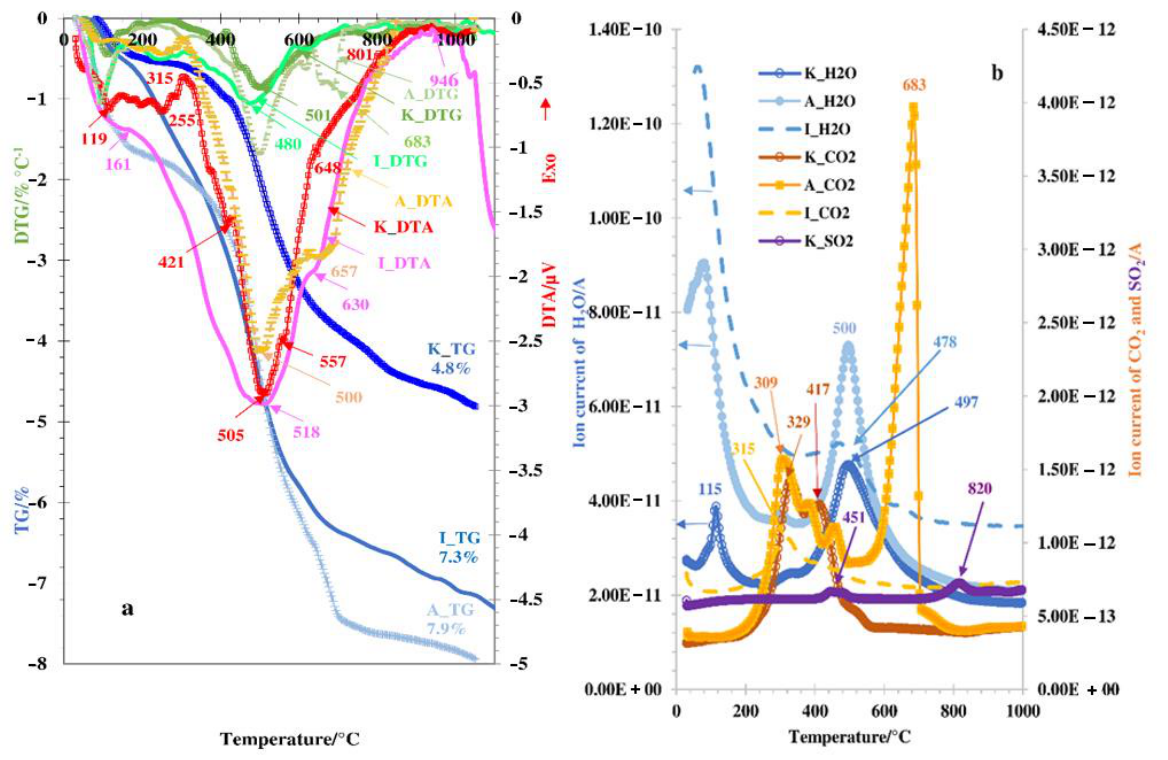
Figure 12. Thermoanalytical curves ( a ) and emission profiles of gaseous compounds ( b ). evolved at thermal treatment of Kunda (K), Arumetsa (A) and illitic (I)